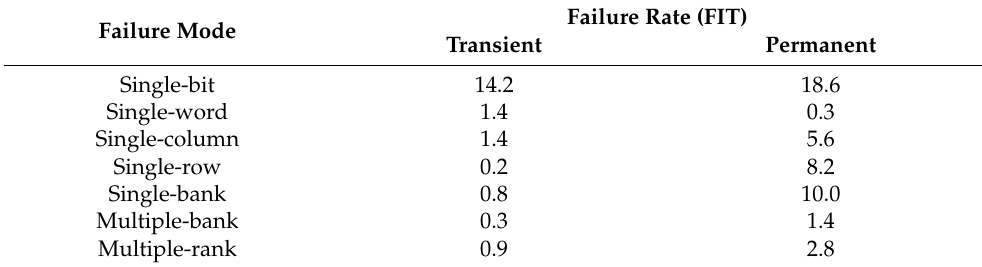
Table 2. Failure rate of each elements in DRAM devices per billion hours (FIT)